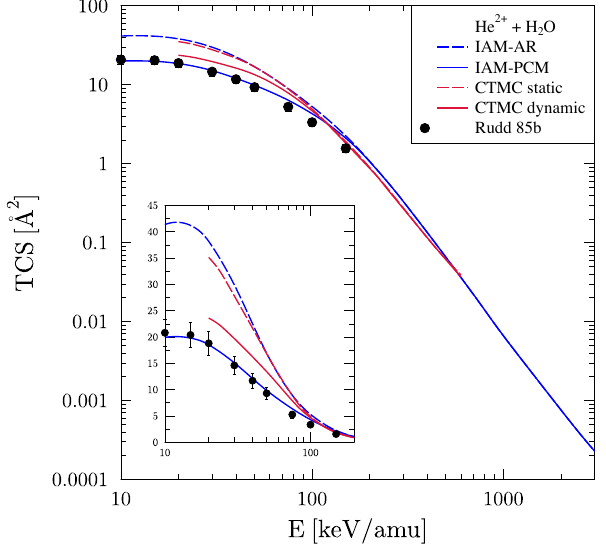
Figure 3. Net electron capture cross section for He 2 + -water collisions. The curves follow the same pattern as described for Figure 2. The experimental data are from Reference